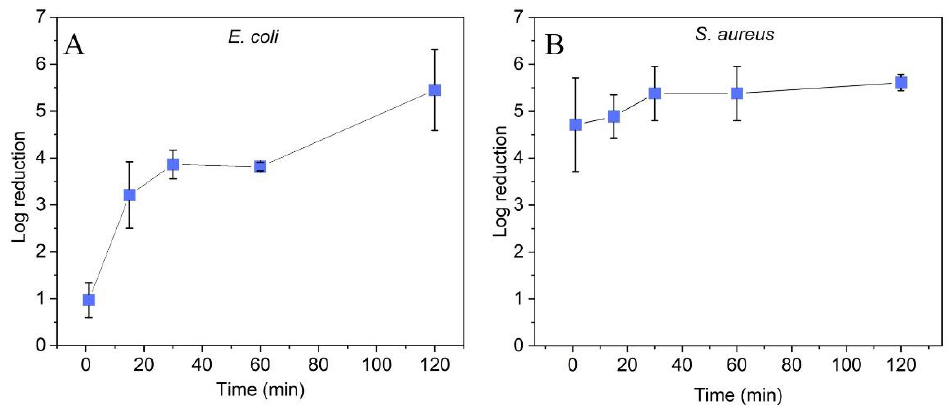
Figure 3. Effect of contact time to ZnO nanoparticle coated adhesive tape surfaces (single ZnO layer) on log reduction of ( A ) E. coli and ( B ) S. aureus . Standard deviation represents the average from three separate experiments.